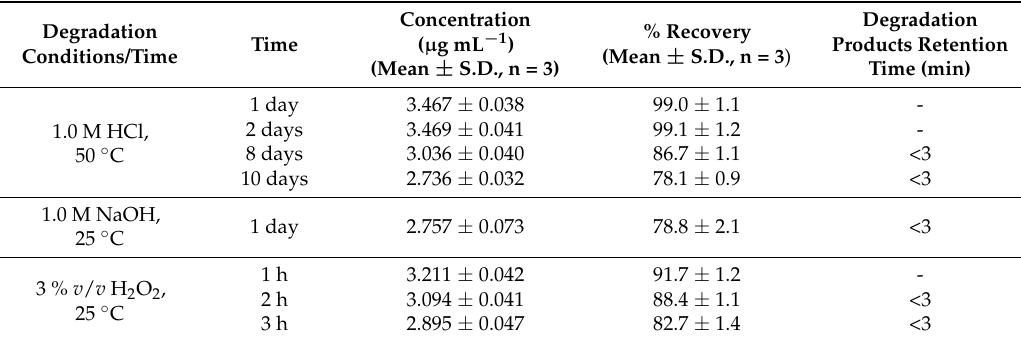
Table 3. Stability data for risedronate by